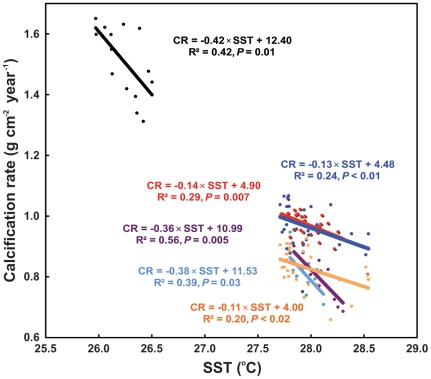
Mean annual calcification rates as a function of average annual sea surface temperature.In massive Porites spp. from Rib Reef, central Great Barrier Reef Australia (black), Montastraea faveolata from Mahahual (dark blue) and Chinchorro Bank, (red), Mesoamerican Barrier Reef System, M. franksi from Mahahual (orange), and Porites astreoides from Mahahual (light blue) and Chinchorro Bank (purple). CR = calcification rate, SST = sea surface temperature.